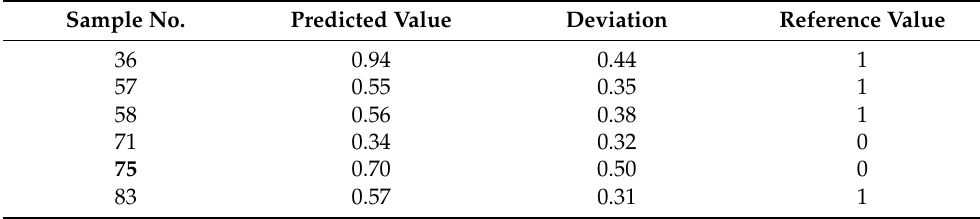
Note: the numbers of samples with false prediction results are highlighted in